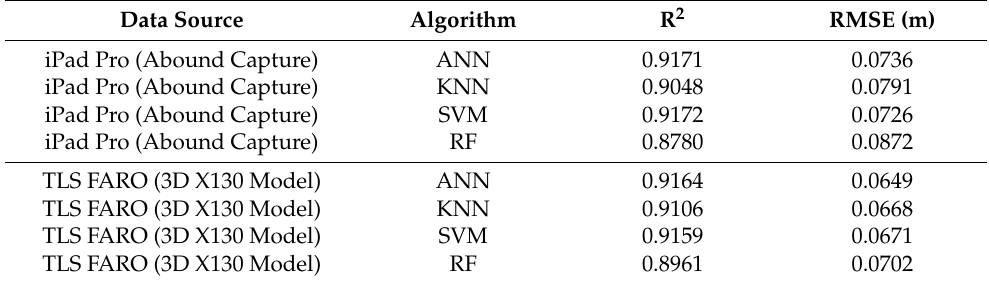
Table 2. Precision statistics for each of the four algorithms applied for data from iPad Pro and TLS FARO.